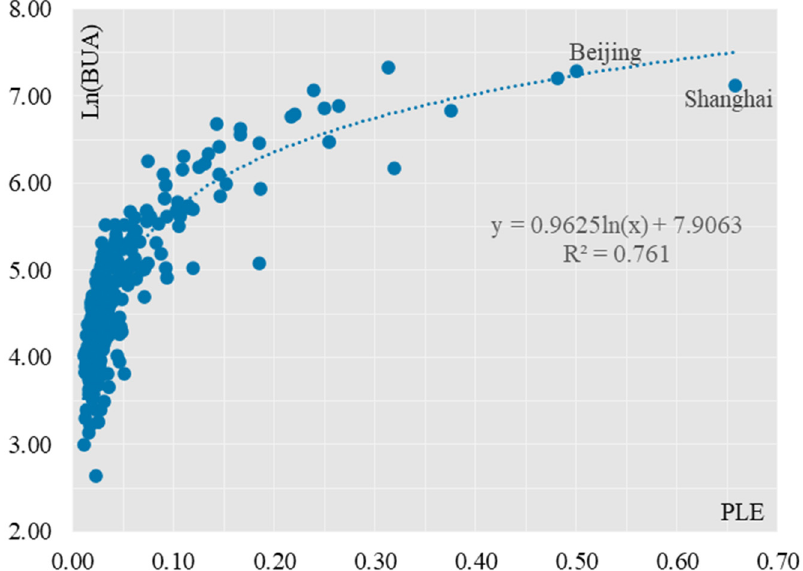
Table 7. Fit between two variables BUA and PLE.